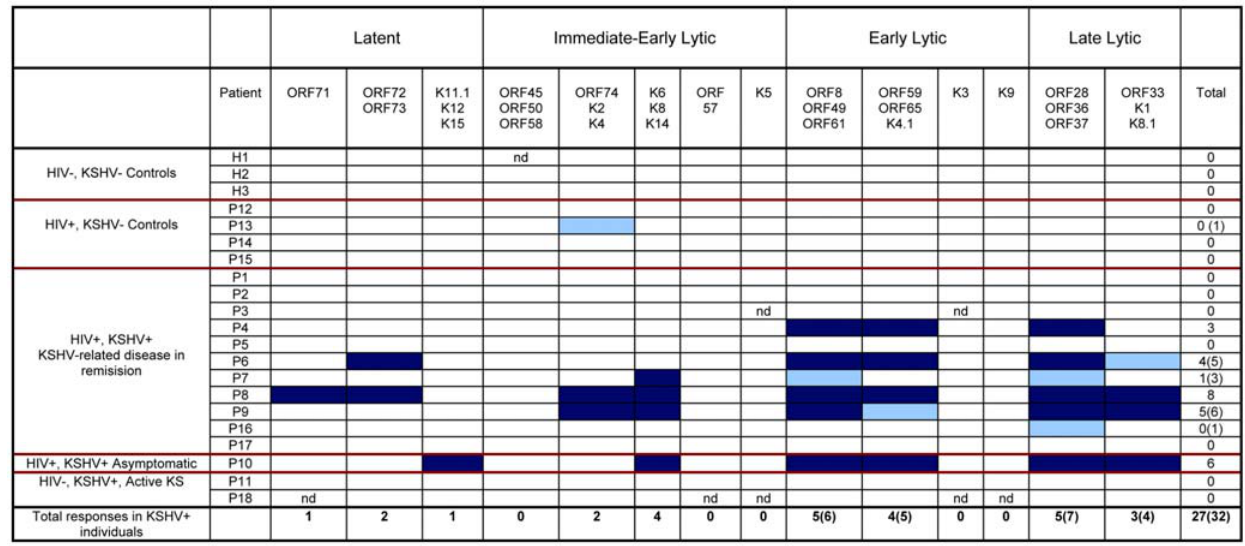
Figure 4. Summary of CD8 responses to KSHV ORFs by all study participants. Dark blue boxes represent positive responses; light blue boxes represent borderline responses; unfilled boxes represent no response; nd indicates not done due to insufficient numbers of available PBMCs.